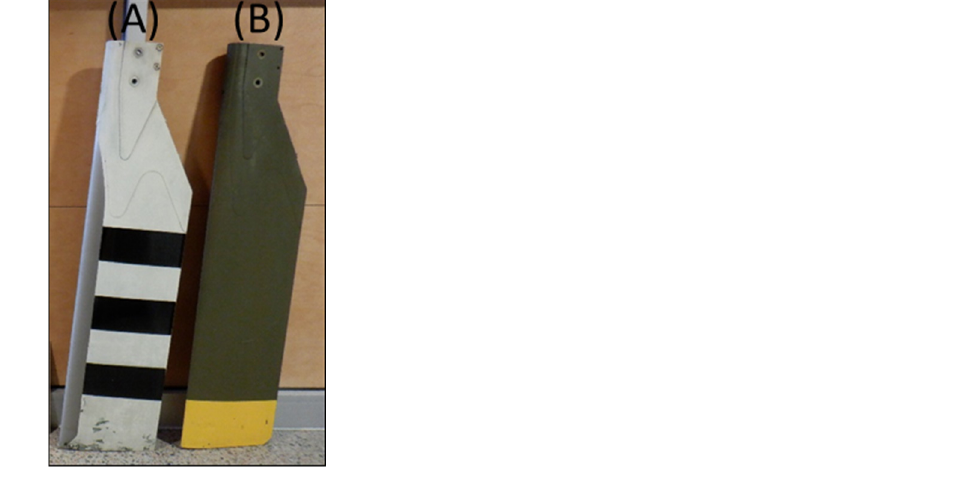
Figure 13. ( A ) Commercial gloss and ( B ) military matte-painted tail blade profiles.